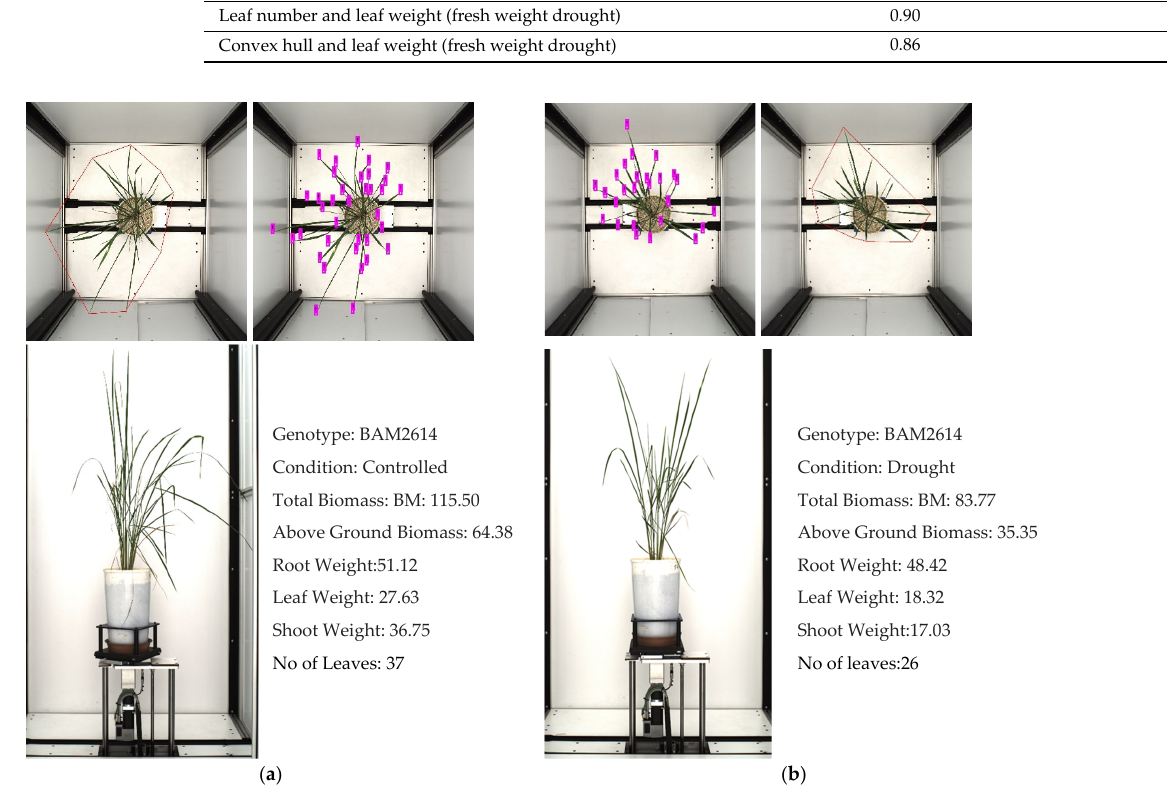
Figure 11. The number of leaves is an important trait associated with biomass in rice. The images show one of the rice phenotypes, BAM 2614, in: ( a ) control treatment, and ( b ) drought treatment . Table 3. Correlation analysis between quantitative traits and image traits.